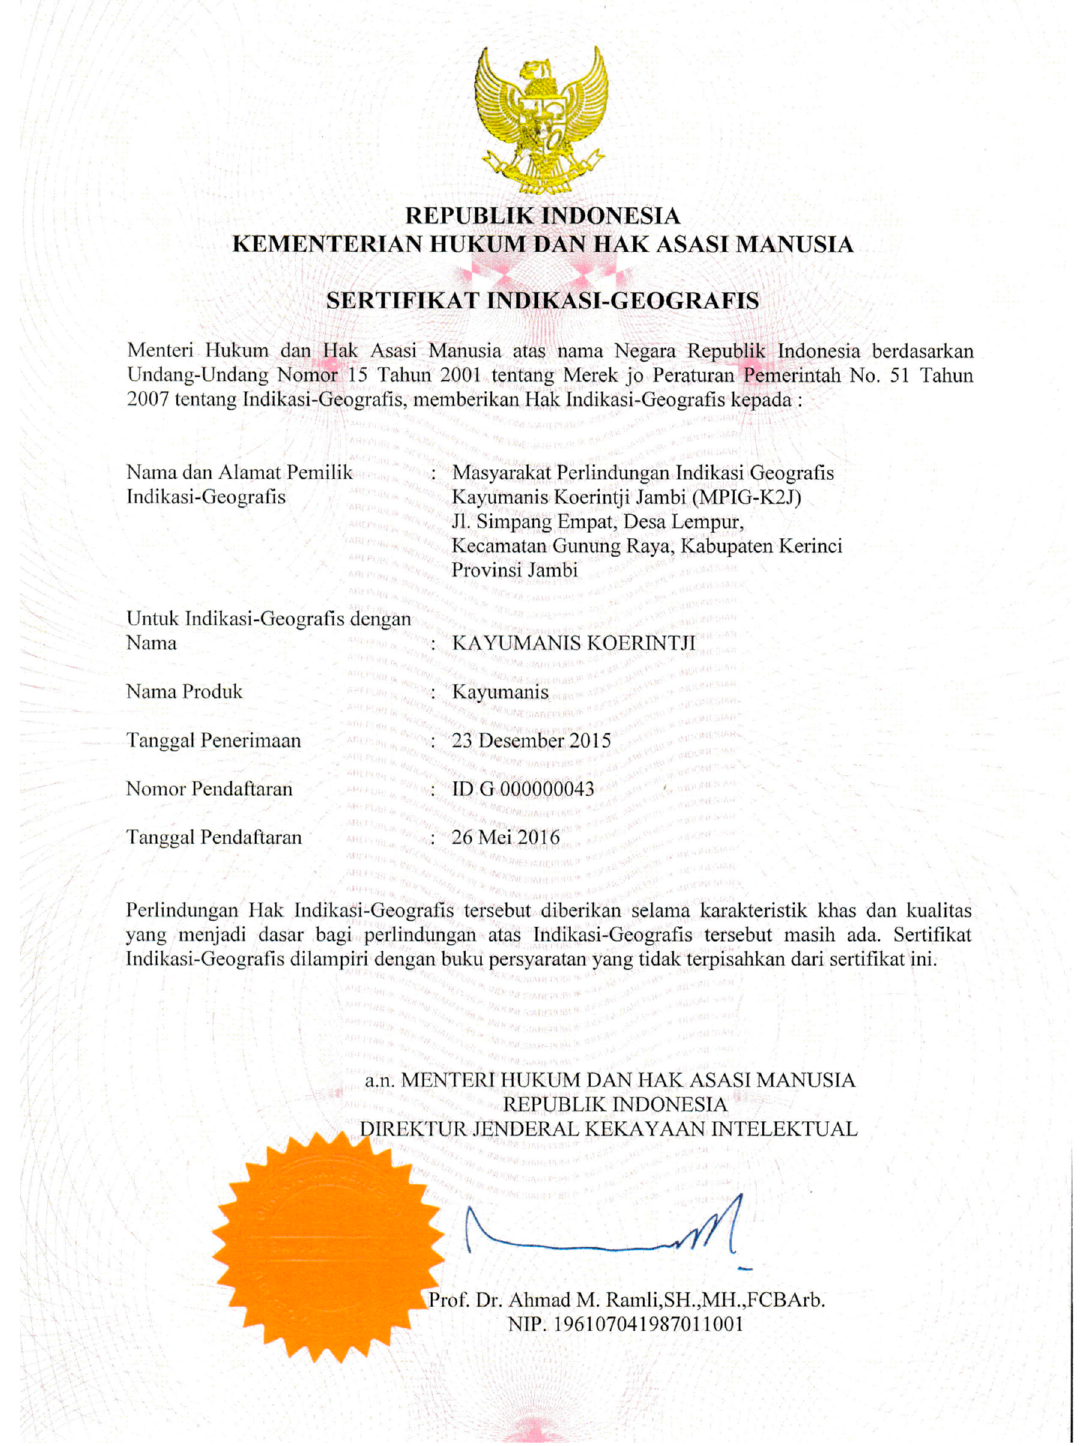
Figure A1. Certificate of Geographical Indication. Source: Handbook of Requirements, MPIG-K2J [Consent for publica- tion].